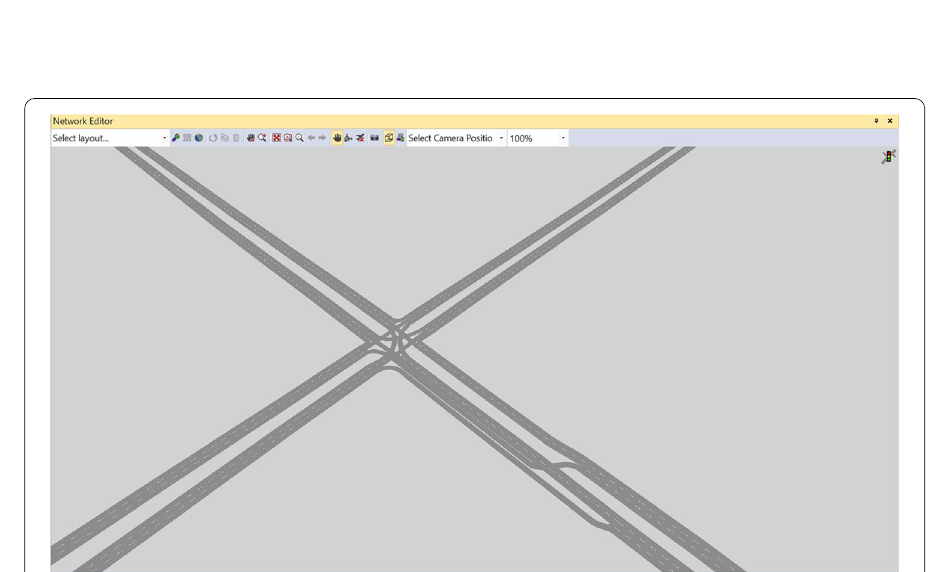
Fig. 6 VISSIM simulation model of Al Sakhara intersection with